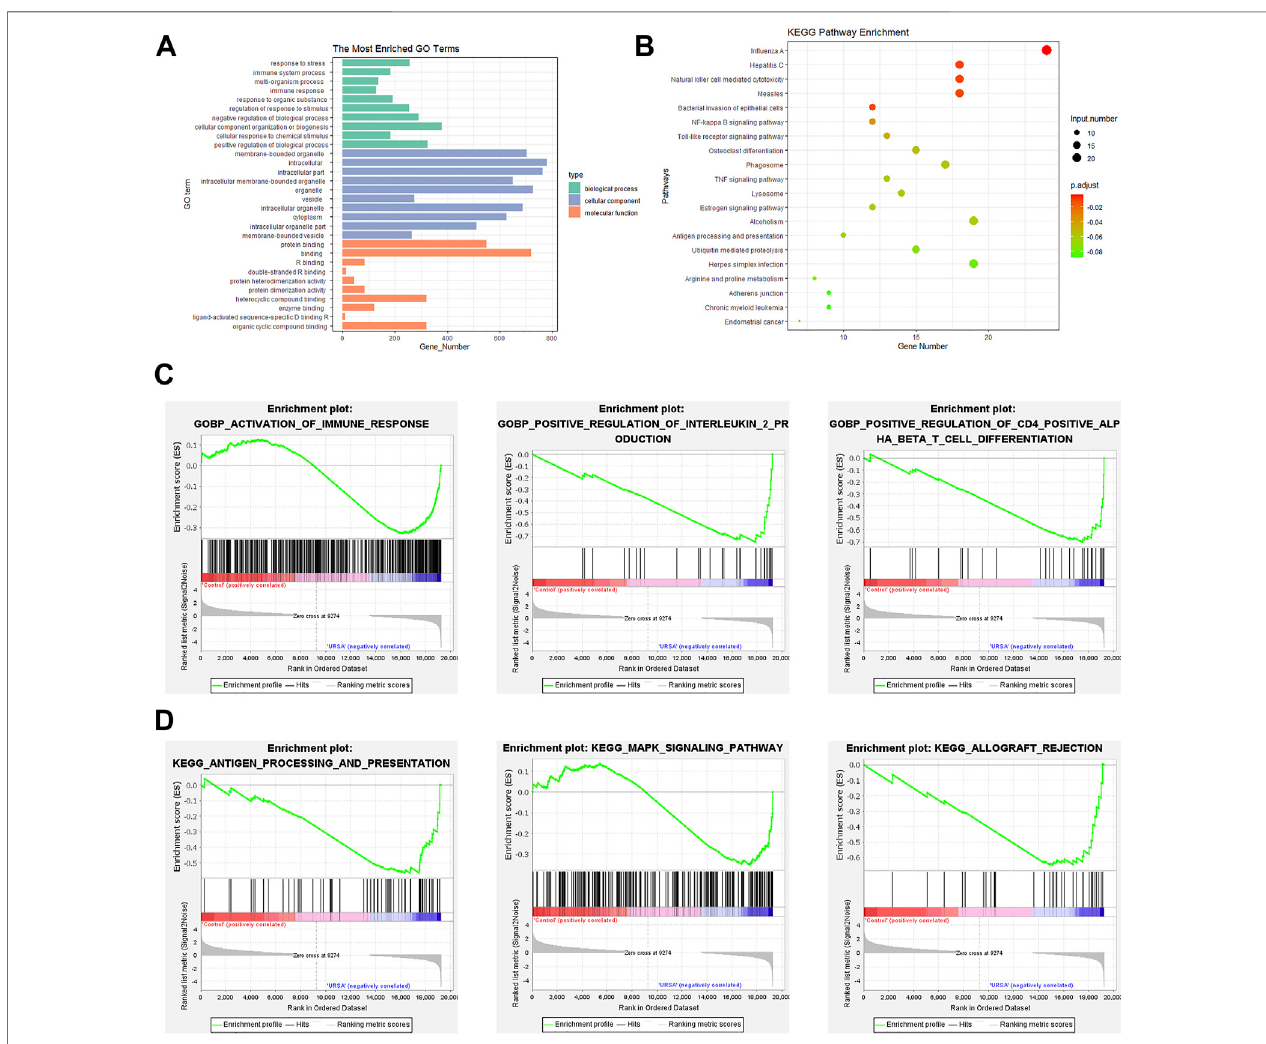
FIGURE 2 | GO and KEGG pathway enrichment analyses and GSEA. GO analysis (A) and KEGG (B) of dysregulated mRNAs. (C) GSEA showed DE mRNAs involved in the BP GO annotations. (D) GSEA showed DE mRNAs in KEGG.